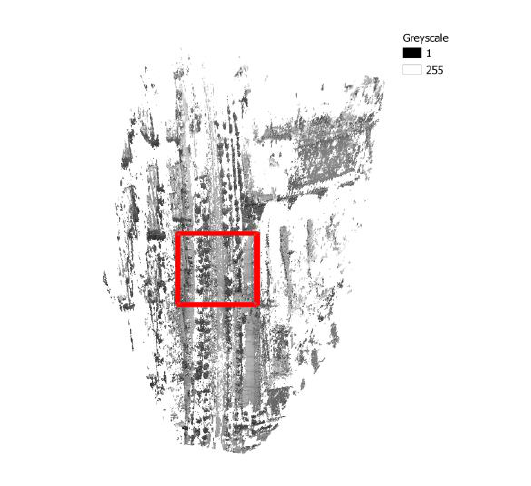
Figure 7. Detail of greyscale map focused on the indicated box.